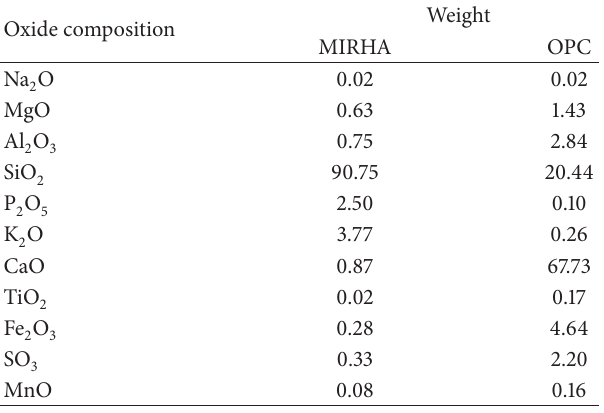
Table 1: Binder properties.